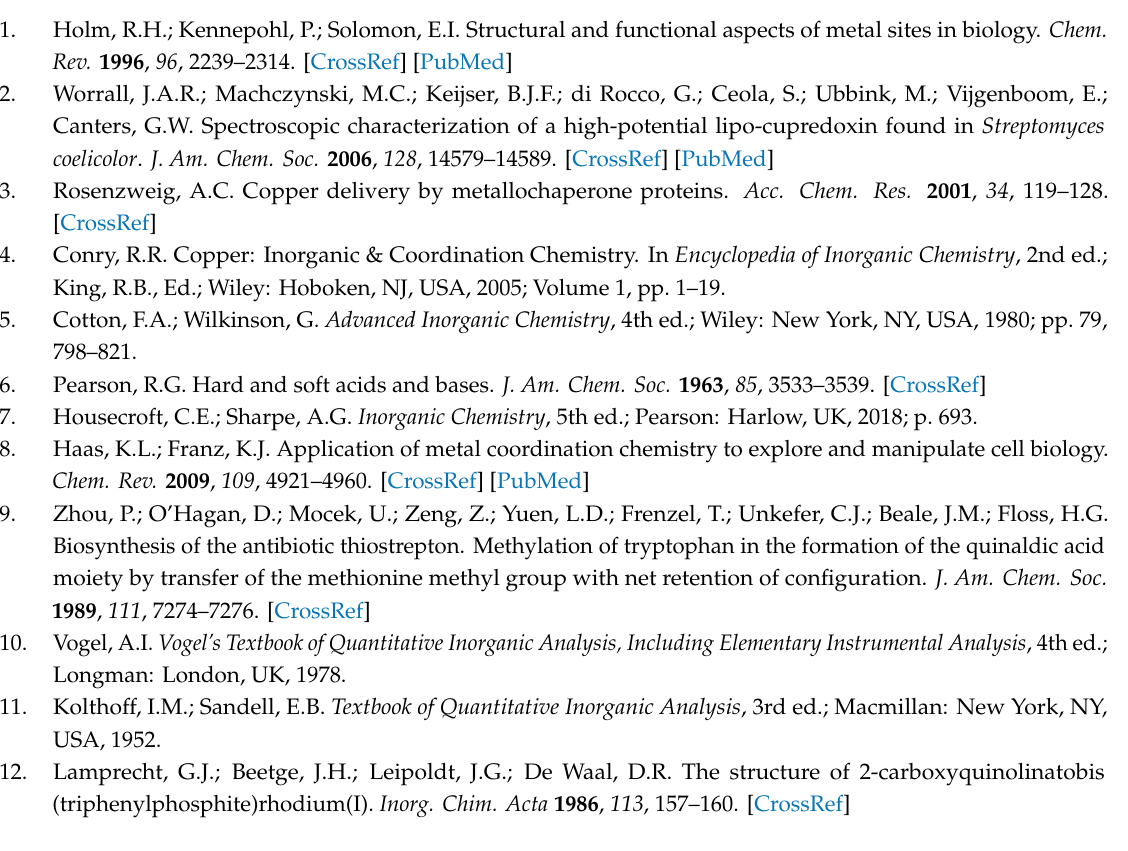
Figure S8: A view along the channels in the structure of [Cu(quin) 2 (pipe) 2 ] · CH 3 CN ( 8 ). Table S4: Intermolecular interactions in [Cu(quin) 10 . Table S5: Hydrogen bonds in compounds 1 – 11 . Figure S12: Infrared spectrum of [Cu(quin) 2 (H 2 O)]. Figures S13–S21: Infrared spectra of 1 – 4 , 6 – 9 and 11